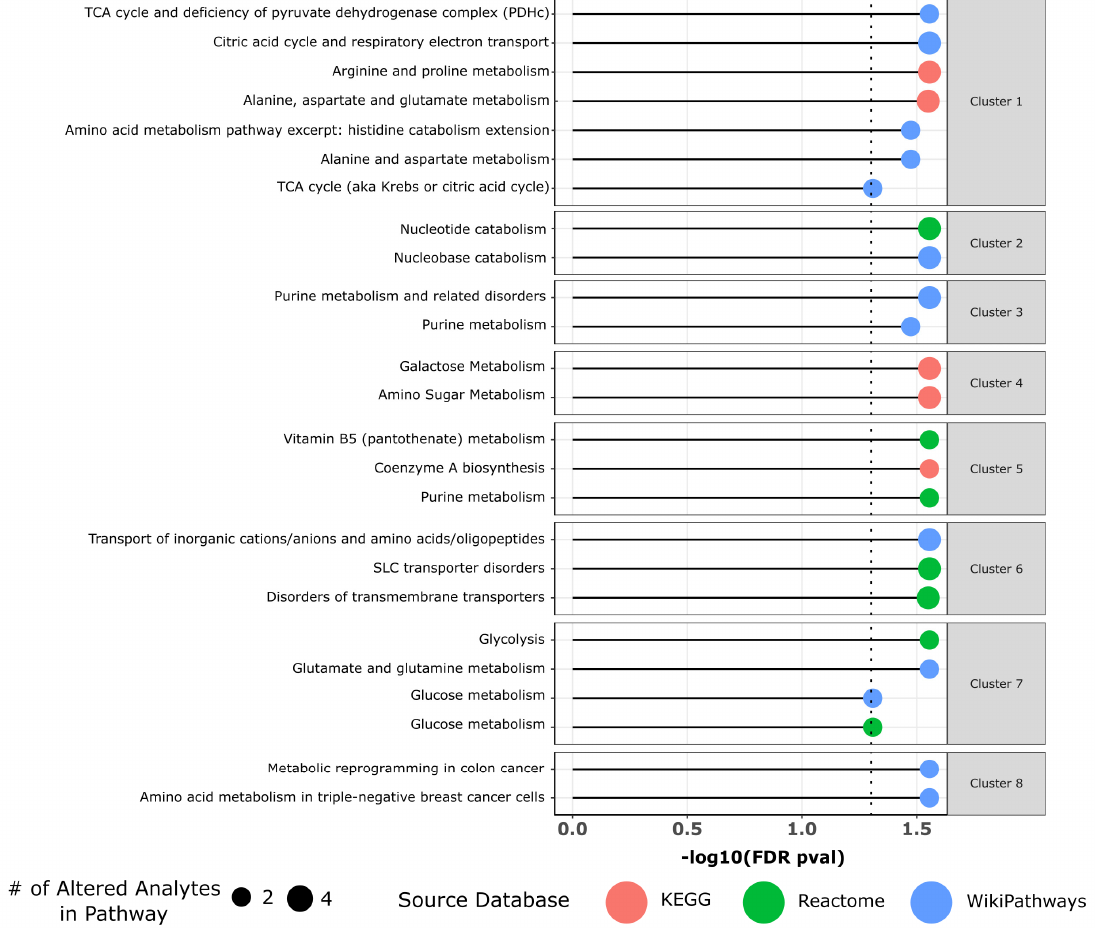
Figure 4. Results of the metabolic pathway enrichment analysis by RaMP-DB [64]. Significantly enriched metabolic pathways from KEGG, Reactome, and WikiPathways are organized into groups.